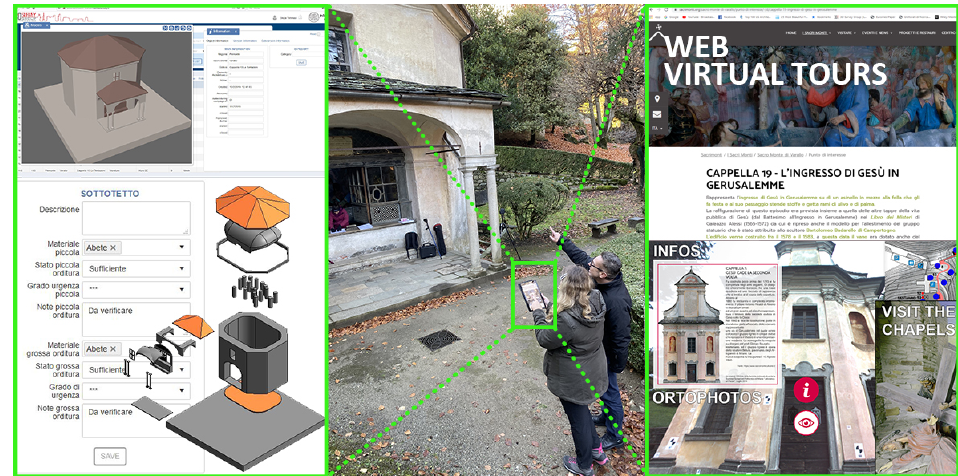
Figure 2 . BIM3DSG can be an useful tool for accessing the heritage including but not limited to conservation